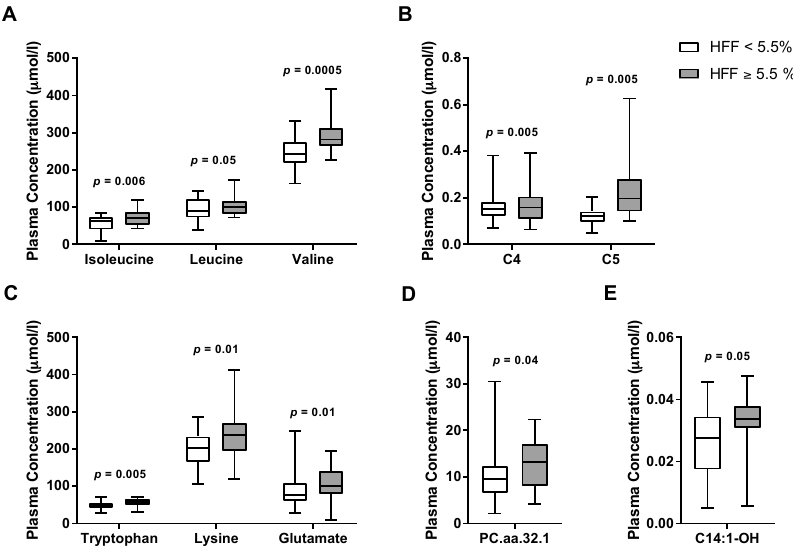
Figure 2. Metabolites associated with NAFLD in obese youth: ( A ) BCAAs, branched-chain amino acids (isoleucine, leucine, and valine); ( B ) C4 and C5; ( C ) tryptophan, lysine, and glutamate; ( D ) PC.aa.C32.1 (long-chain phosphatidylcholine C32:1); and ( E ) C14:1-OH (Hydroxytetradecenoylcarnitine). Statistical comparisons between the two groups were made by Student’s t -tests.